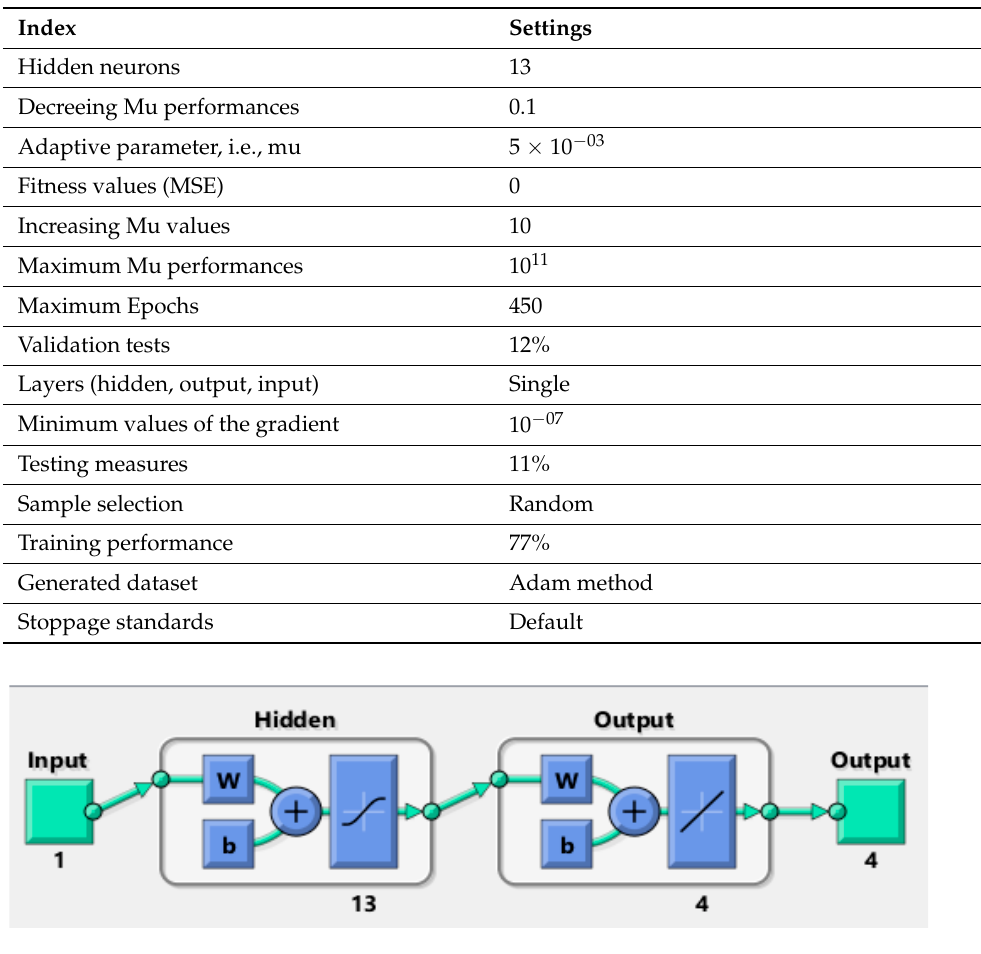
Table 1. Parameter values to perform the SCGNNs.